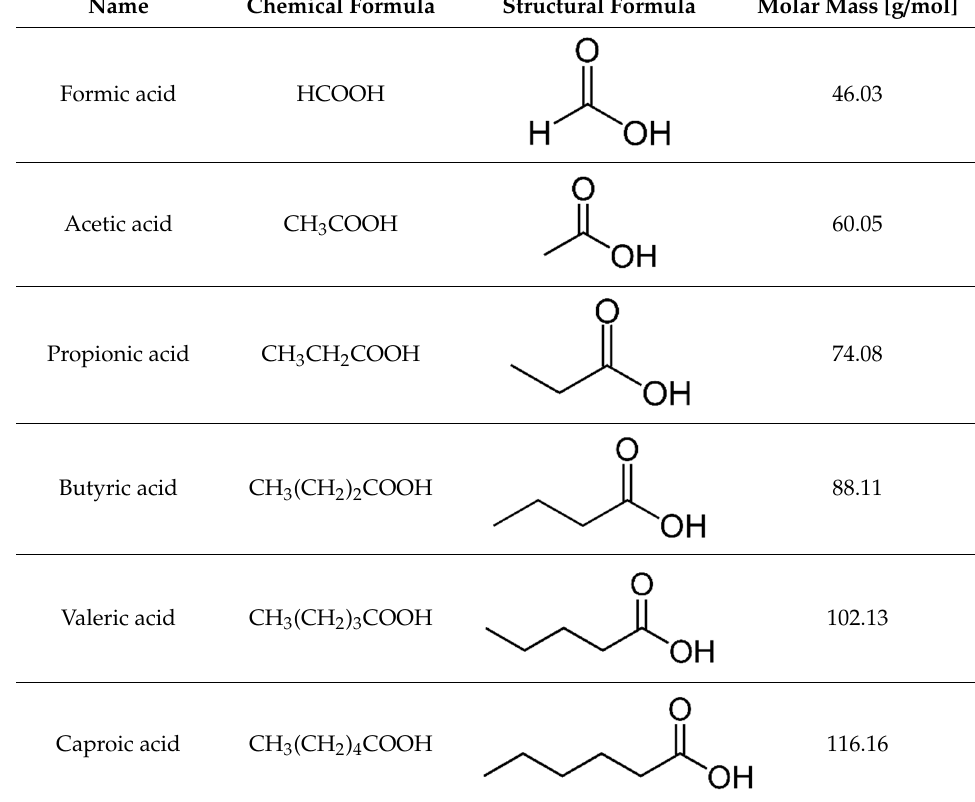
Table 1. Chemical and structural formulas of short-chain fatty acids (SCFAs) [29].